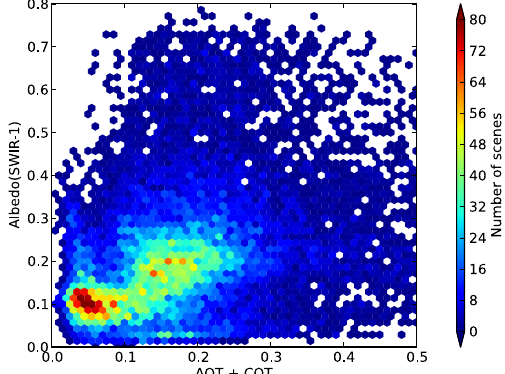
Figure 9. Ensemble of surface albedo at SWIR-1 and scattering optical thickness (aerosol plus cirrus optical thickness, AOT + COT) at 550nm used for the full-physics retrieval simulations. The color scale counts occurrence of